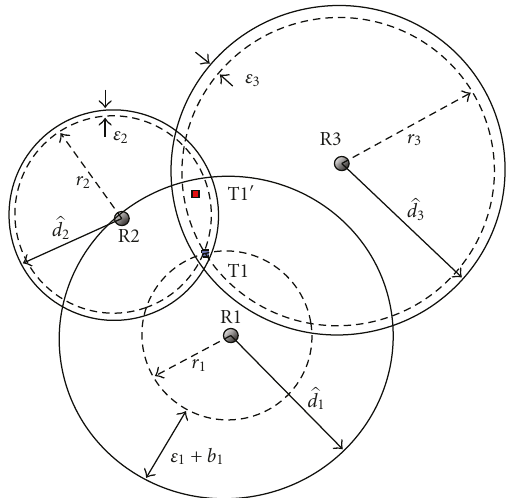
Figure 2: Demonstration for the hypothesis test. The solid circles are produced by estimated distances and dashed circles are produced by true distances. R2 and R3 are in LOS situation and estimated distances are only a ff ected by measurement noise. R1 is in NLOS situation; estimated distance is a ff ected by measurement noise and NLOS